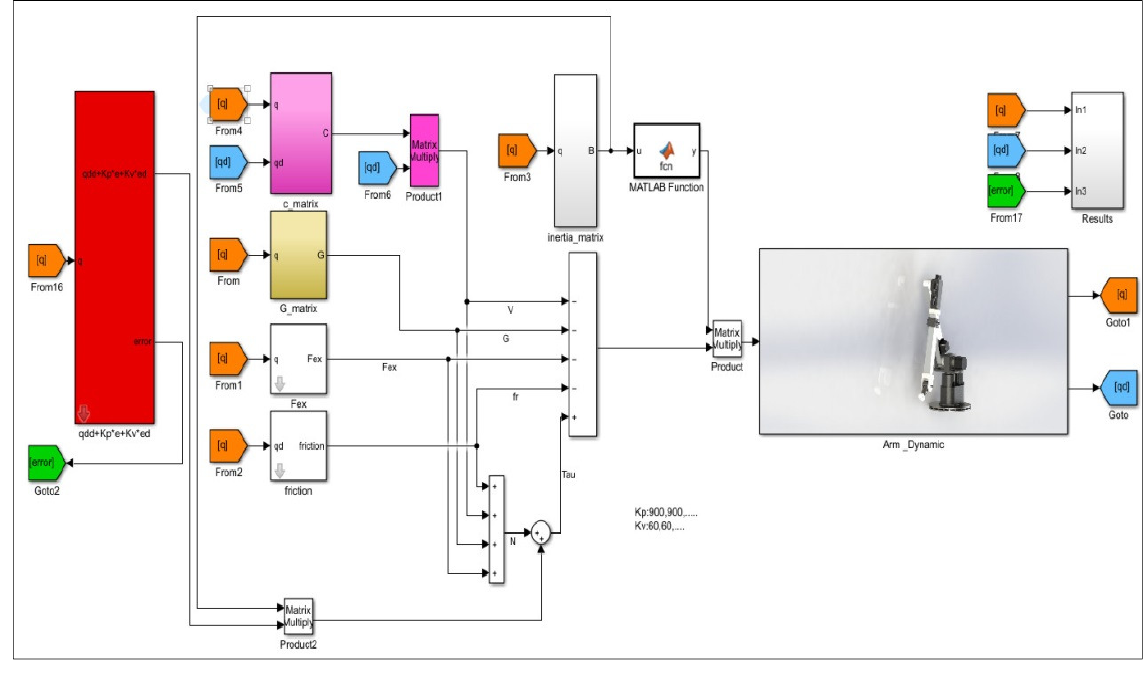
Fig. 7. Matlab Simulink System.